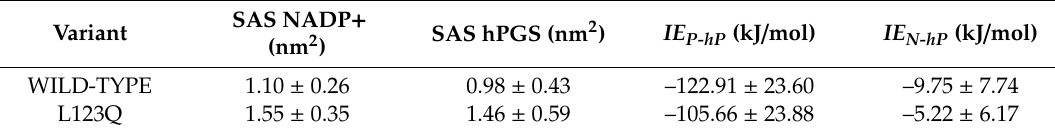
Table 1. Structural and energetic descriptors calculated over 1000 ns MD simulations. Data are reported as average ± standard deviation, SAS represents the solvent-accessible surface of either NADP + or hPGS, IE P-hP is the interaction energy between protein and hPGS, IE N-hP is the interaction energy between NADP + and